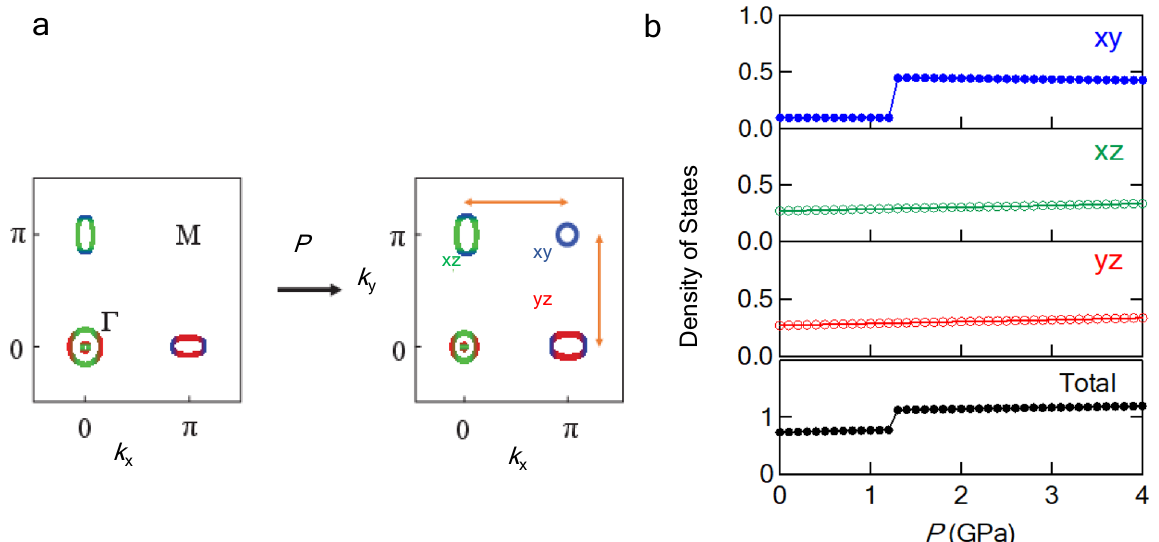
Figure 1. Contribution of each orbital to unfolded Fermi surfaces and the density of states (DOS). ( a ) Schematic Fermi surfaces of pure FeSe in a tetragonal phase theoretically derived at ambient pressure 5–10 and high pressure 16,21 . The Fermi surfaces colored in green, red, and blue represent d xz , d yz , and d xy orbitals, respectively. In a high-pressure regime, the antiferromagnetic (AF) order can be induced owing to the nesting of d xy orbitals between points M and X, as indicated by arrows. ( b ) The DOS originating from d xy , d xz , and d yz orbitals and the total DOS calculated theoretically based on the crystal structure of 10% S-substituted